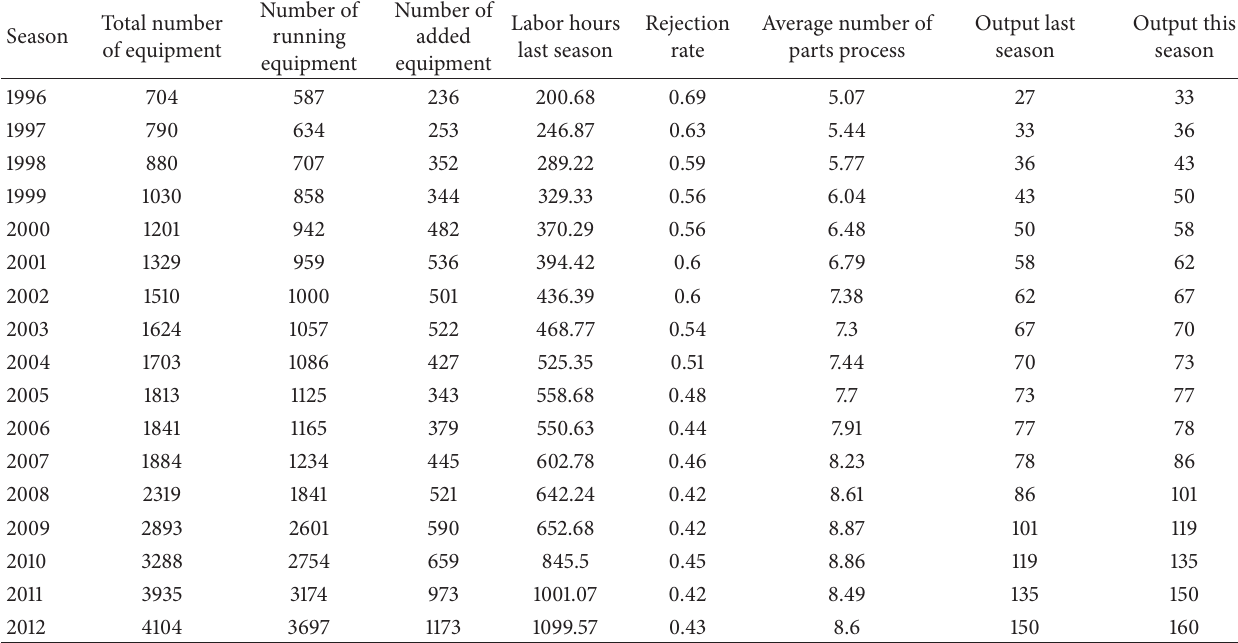
Table 1: Basic datum which affects output prediction in an aviation manufacturing enterprise.